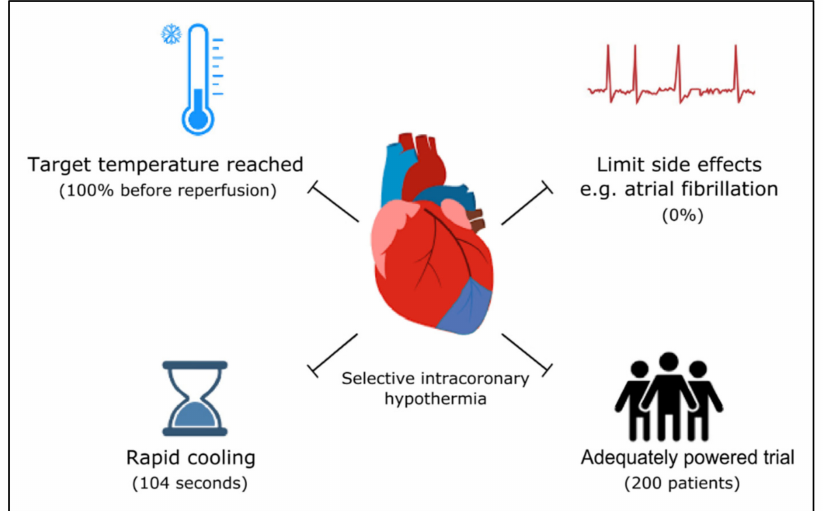
Figure 2. Important requirements for successful hypothermic cardioprotection in patients with ST- elevation myocardial infarction. In parentheses are the numbers related to selective intracoronary hypothermia from the ongoing EURO-ICE